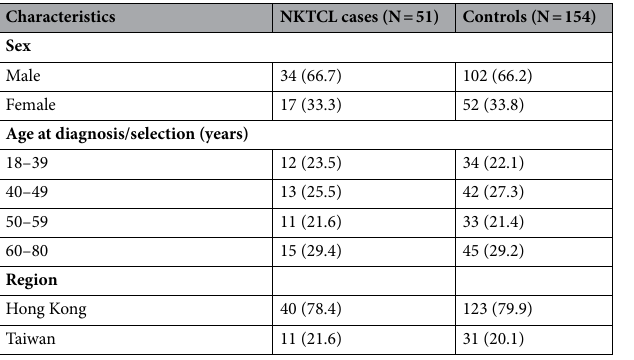
Table 1. Characteristics of study population, by NK-T cell lymphoma (NKTCL) status in Hong Kong and